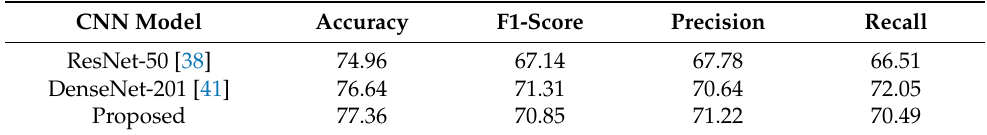
Table 16. Comparison of our proposed model with the second- and third-best models of Table 13 for open-world configuration (unit: